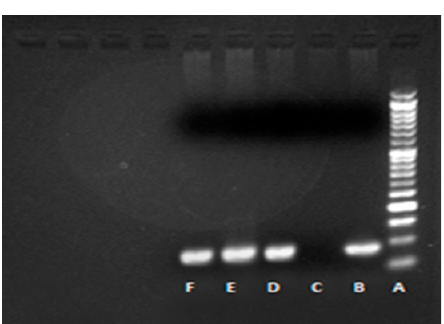
gene. Lanes: A- 50bp DNA Fig. 2. Gel Electrophoresis for bla KPC ladder, B-Positive control, C-Negative control, D,E,F are test isolates showing bla gene at KPC